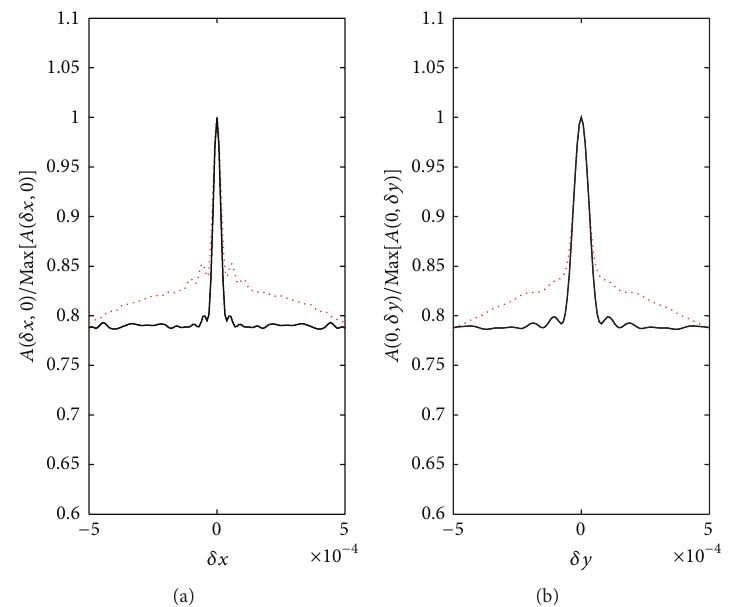
Figure 9: 𝑥 -cuts (a) and 𝑦 -cuts (b) of the central peak of the 2D autocorrelations of the experimental (dotted red lines) and simulated (solid black lines) speckle-like interferometric out-of-focus patterns. The 𝑥 -axes are expressed in meters, while the 𝑦 -axes represent normalized amplitudes (no unit).